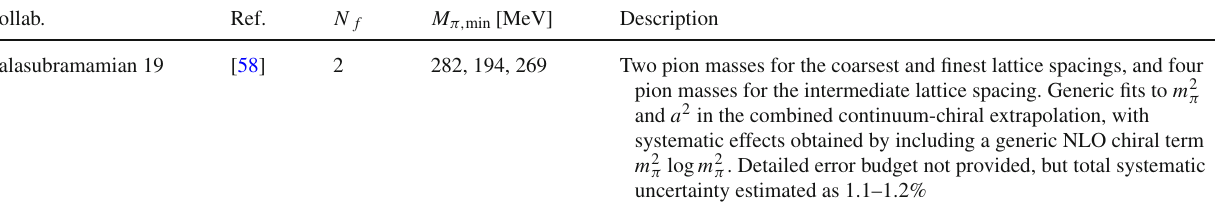
Table 141 Chiral extrapolation/minimum pion mass in determinations of the B - and B s -meson decay constants for N f = 2 simulations. For actions with multiple species of pions, masses quoted are the RMS pion masses (where available). The different M π, min entries correspond to the different lattice spacings Collab.